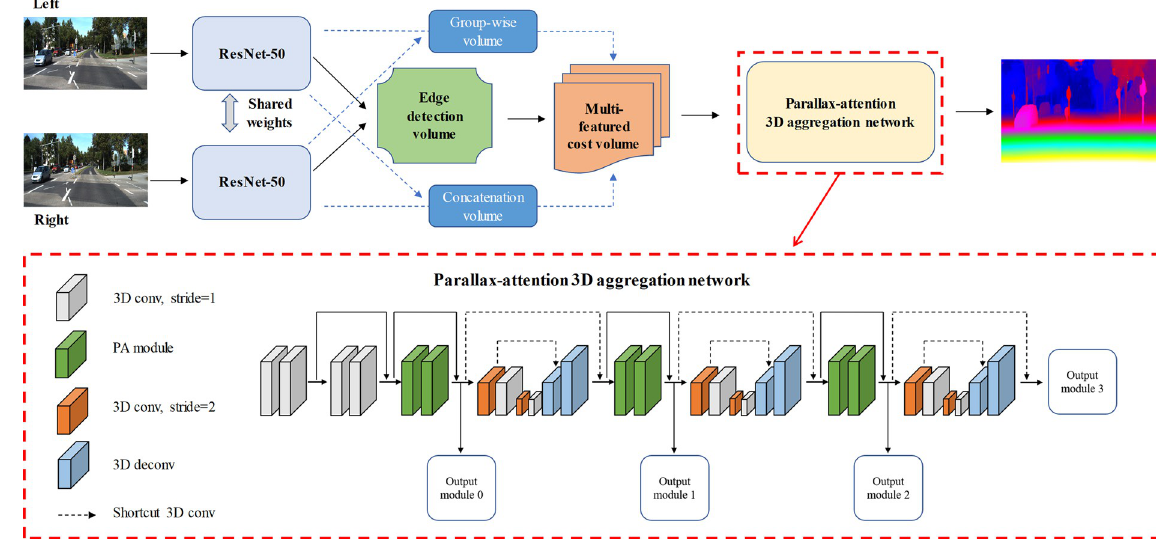
Fig 2. Diagrammatic sketch of PA-Net. It is constructed based on GWC-Net by adding edge-detection branch in feature extraction structure and applying PA module in the architecture of the 3D aggregation network. The left and corresponding right images are fed to a weight-sharing feature extraction pipeline, which consisting of a ResNet-50 network for feature maps calculation. It includes three branches (edge detection, group-wise correlation [13], and concatenation branches). Thereafter, a multi-featured integration cost volume is constructed by those branches and it will finally be fed into a parallax-attention 3D aggregation network for disparity regression.